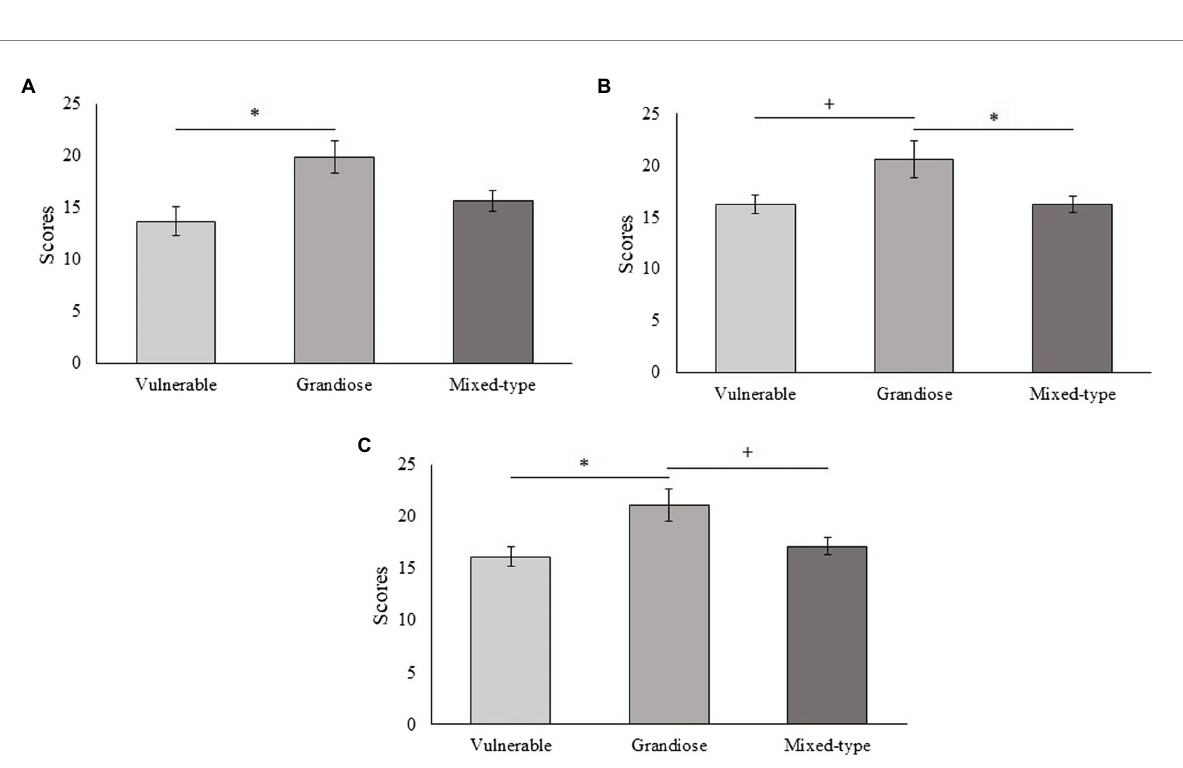
FIGURE 4 Differences between the three narcissism categories on the psychopathic traits. (A) Fearlessness [ F (2,44) = 3.499, p = 0.039, η 2 = 0.137]. (B) Stress immunity [